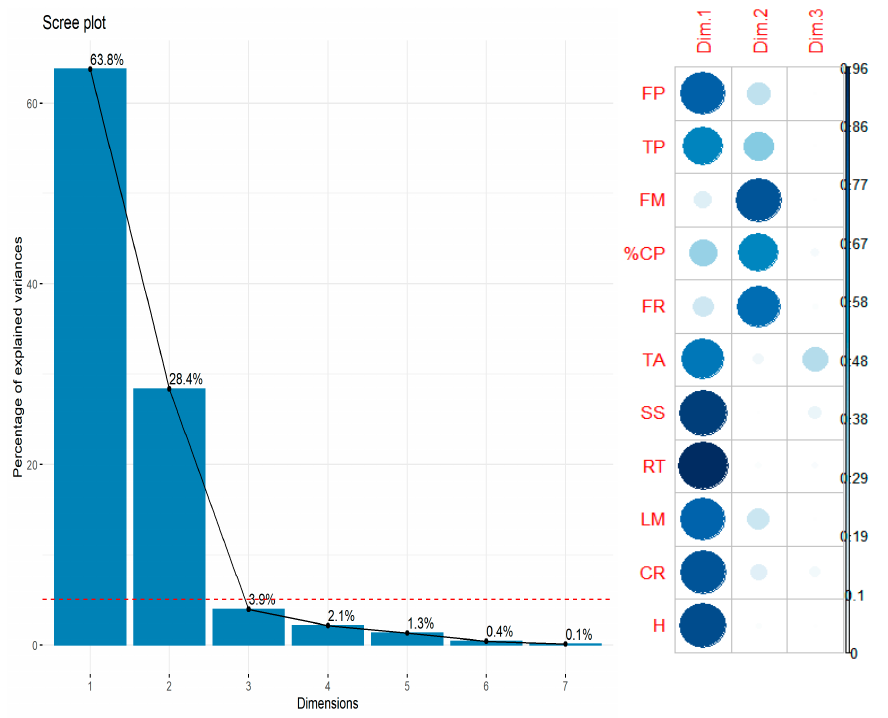
Figure 8. Decomposed principal component analysis for the variables in the study concerning the effect of bare-root plants with different crown diameters (5, 7, 9, 11, 13, 15, 17, and 19 mm) on the production and fruit quality parameters of strawberry plants cv. Pircinque. Caption: FP = fruits per plant; TP = total production; FM = fresh mass; % CP = commercial percentage; SS = content of soluble solids; FR = firmness; TA = titratable acidity; RT = soluble solids/titratable acidity ratio; LM = epidermis luminosity; CR = epidermis chroma; and H = epidermis hue angle.